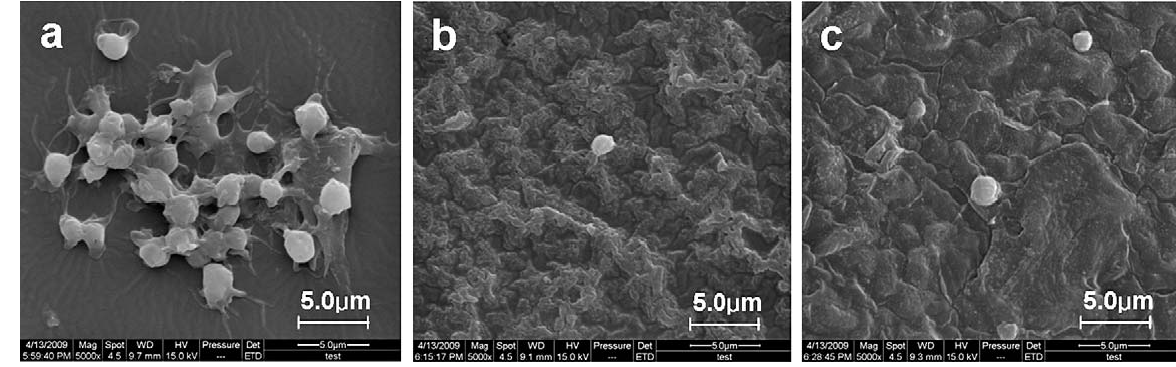
Figure 13. Scanning electron micrographs of PVC surface after being contacted with fresh platelet enriched plasma for ( a ) control PVC; ( b ) heparin/iron coated; and ( c ) dextran sulfate/heparin/iron coated samples (Reprinted with permission from [87]. Copyright 2009